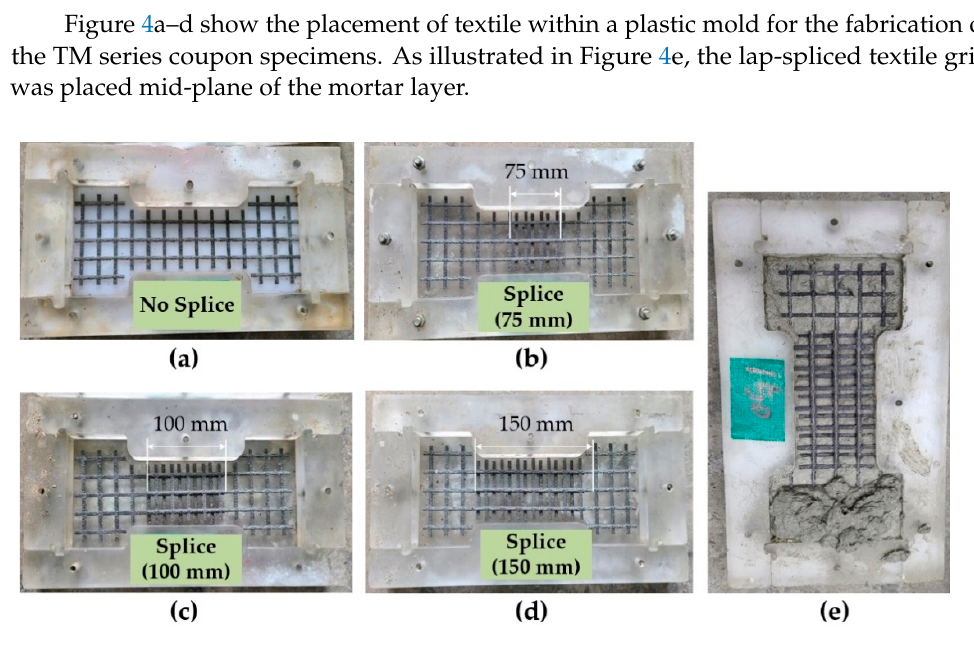
Figure 4. Textile grid placement for specimens with mortar (TM series): ( a ) no splice; ( b ) 75 mm lap splice; ( c ) 100 mm lap splice; ( d ) 150 mm lap splice; and ( e ) mortar placement (TM-150).